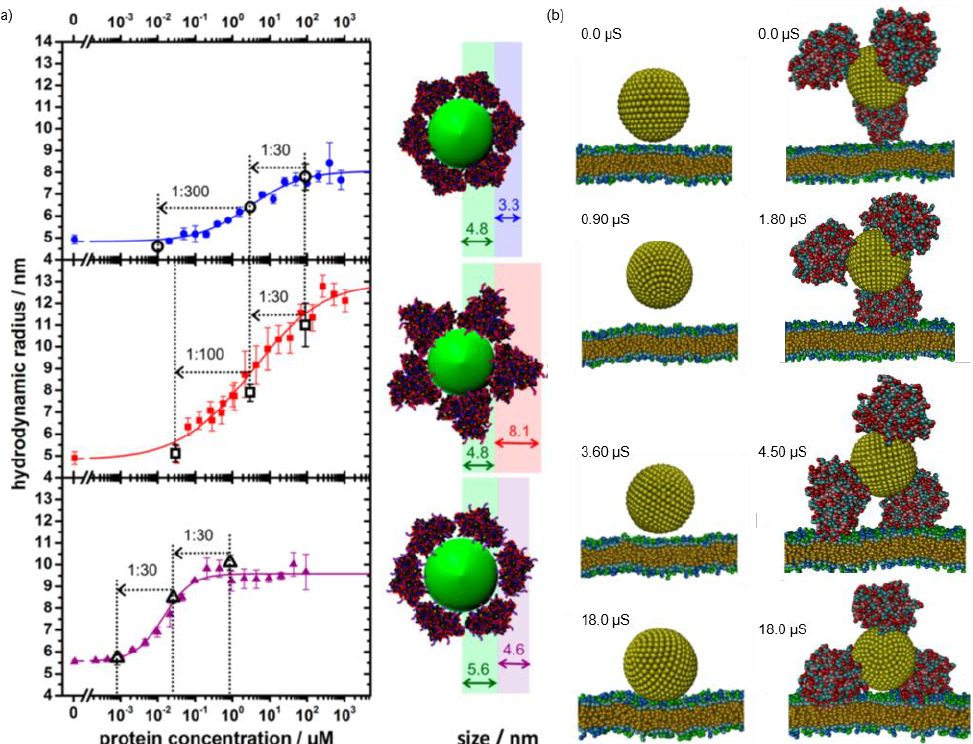
Figure 8. Experimental and simulated demonstrations of protein coated NPs. ( a ) Adsorption of (top) plain HSA, (middle) HSAsuc and (bottom) HSAam onto DHLA-QDs as a function of protein concentrations and the corresponding schematic depictions of the hydrodynamic radii increase as a result of the protein adsorption. Reprinted with permission from [129]. Copyright (2014) American Chemical Society. ( b ) Simulated time sequence of the snapshots of the interactions between macrophage cell membranes and positively charged NPs. Left panel: in the absence of serum proteins. Right panel: in the presence of serum proteins. Reproduced with permission from [130].